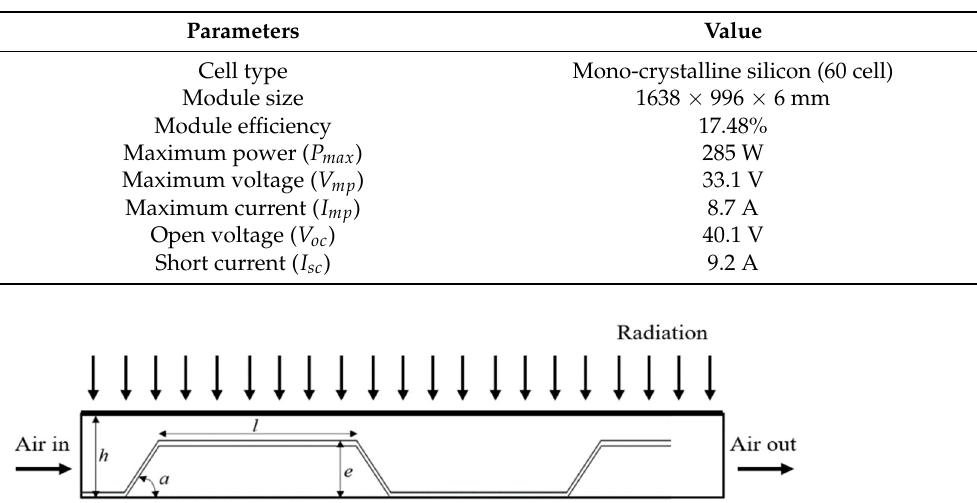
Figure 2. Concept of perforated thermal absorber (baffle) in the air-type PVT collector.